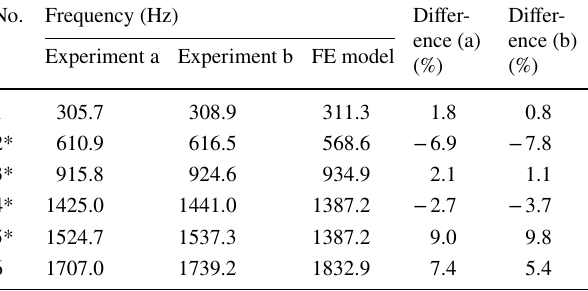
*The frequency characteristic for the hidden end part of a rock